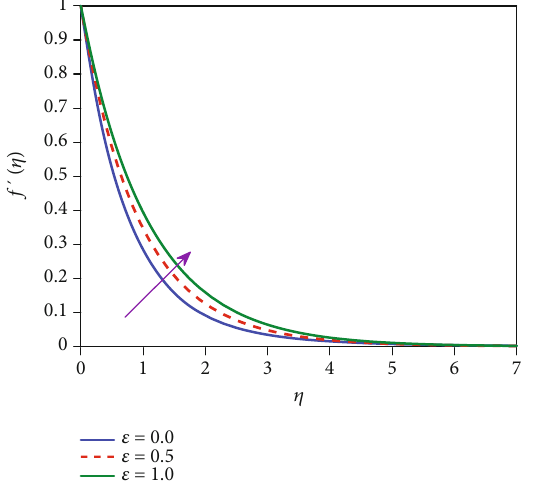
Figure 2: E ff ect of ε on the primary velocity f ′ ð η Þ